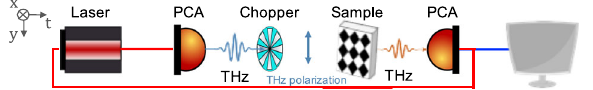
Fig. 5 Terahertz time-domain setup. System based on photo- conductive antennas for the generation and detection of terahertz waves in transmission mode. The blue arrow shows the polarization of THz light.